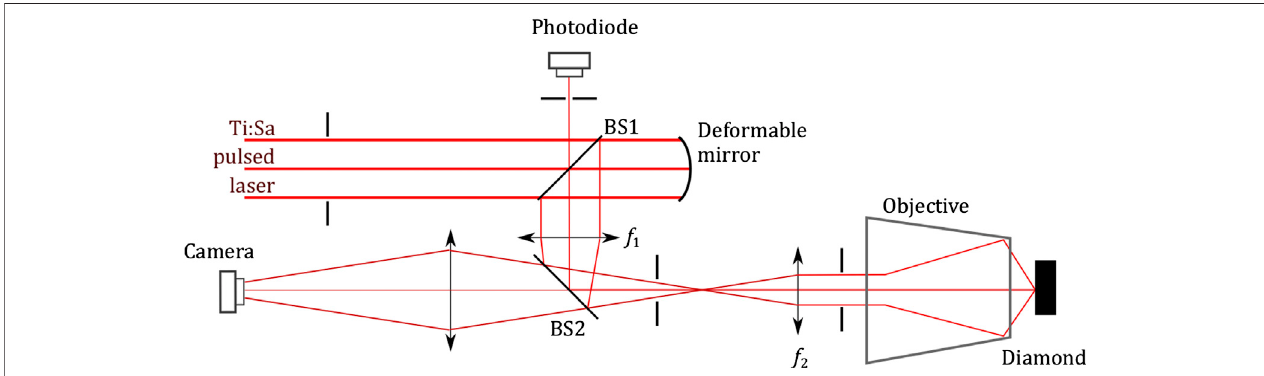
FIGURE 3 | Schematic representation of the optical system. The laser beam is re fl ected by a deformable mirror which is imaged on the pupil of the objective. The same objective is used to acquire a microscopic image ofthe sample, during operations, with a CCD camera. A fast photodiode is used to monitor the beam conditions and as time reference for measurements with laser-induced charge generation.